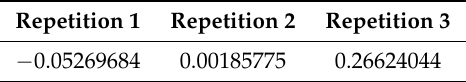
Table A3. SVM features’ predictive